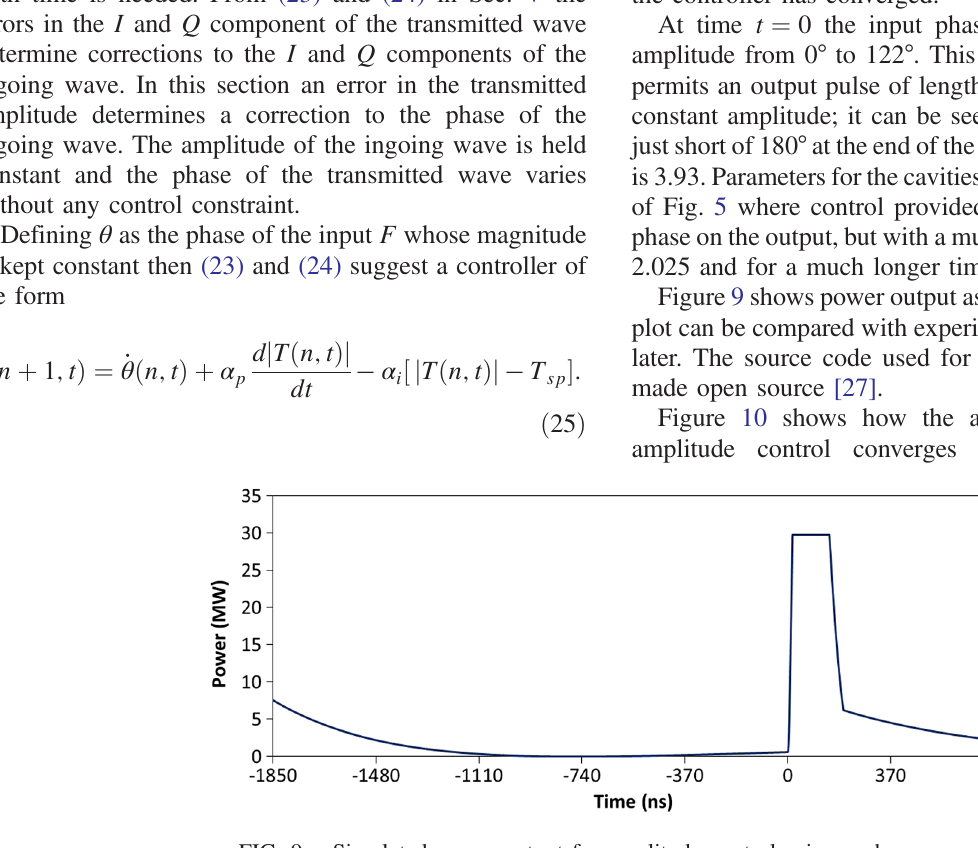
FIG. 9. Simulated power output for amplitude control using a phase